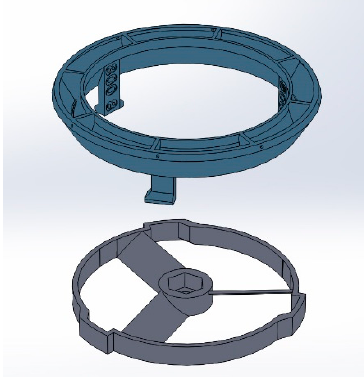
Figure 4. Fan hub assembly.